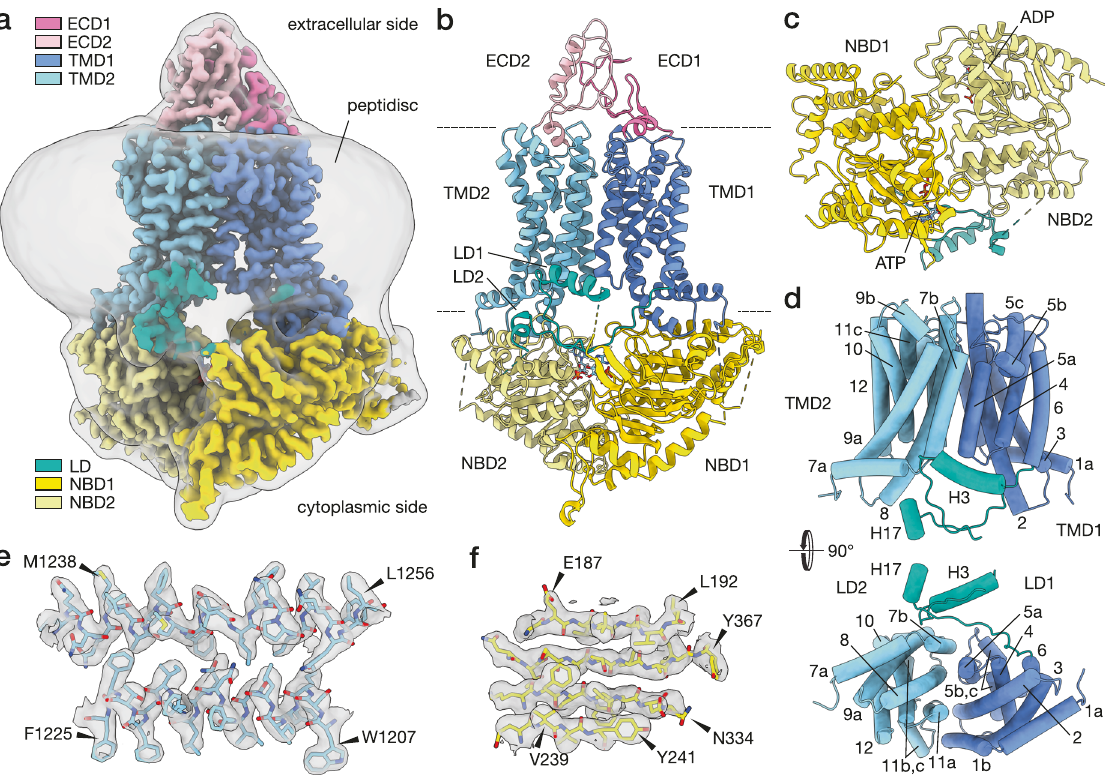
Fig. 1 Structural features of Pdr5. a Depicted here is the cryo-EM map of Pdr5 in inward-open conformation (ADP-Pdr5). The map is coloured according to the domain organisation (see key). The grey transparent envelope surrounding the protein is a Gaussian- fi ltered (2 σ ) version of the same map, showing the extent and shape of the peptidisc shell around Pdr5. b Atomic model of Pdr5 built and re fi ned against the map, in cartoon representation. c Top view (cytoplasmic side) of the nucleotide-binding domains of Pdr5, showing the position of the bound nucleotides. The linker domain is also depicted. d Side and top views of the transmembrane domain of Pdr5 with α -helices shown schematically as cylinders and numbered sequentially (TH1a – 12) from the N-terminus (cf. Supplementary Fig. 5 and S6). This panel also includes the linker domain and its two helices H3 and H17. e , f Two portions of the ADP-Pdr5 cryo-EM map, showing the reconstructed volume around representative secondary structural features: e α -helices TH7b and TH8 of TMD1 domain and ( f ) a β -sheet in NBD1 domain. Arrowheads point to amino acid residues that have been arbitrarily chosen for orientation purposes. Abbreviations: ECD, extracellular domain; LD, linker domain; NBD, nucleotide-binding domain; TMD, transmembrane